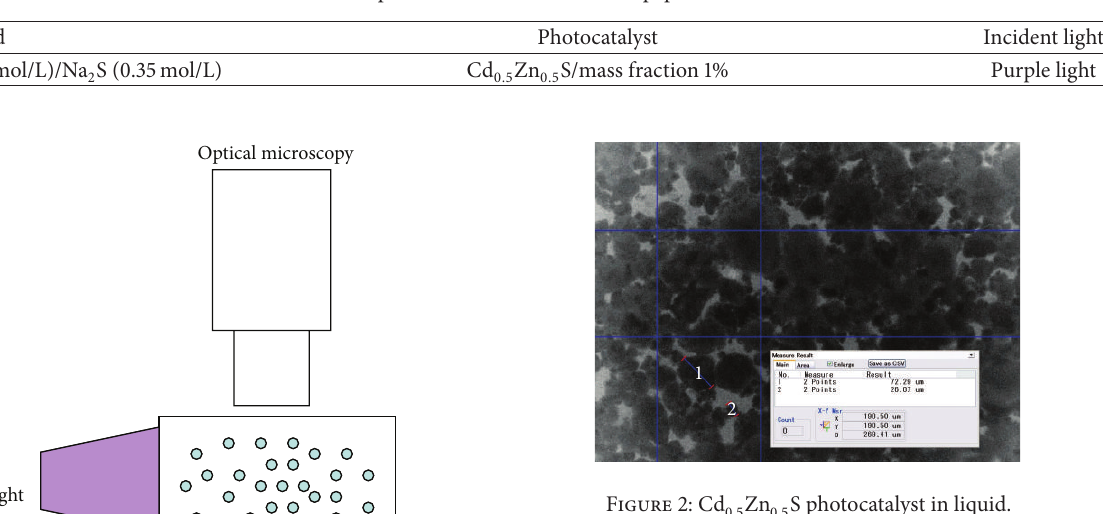
Table 1: Experimental conditions in this paper.